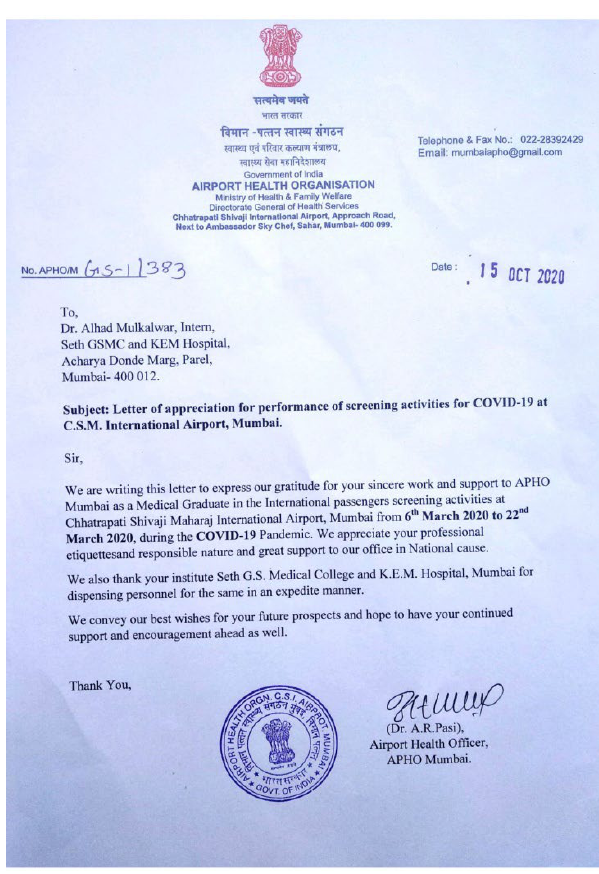
Figure 2 . Appreciation Letter Received from the Airport Health Authority,